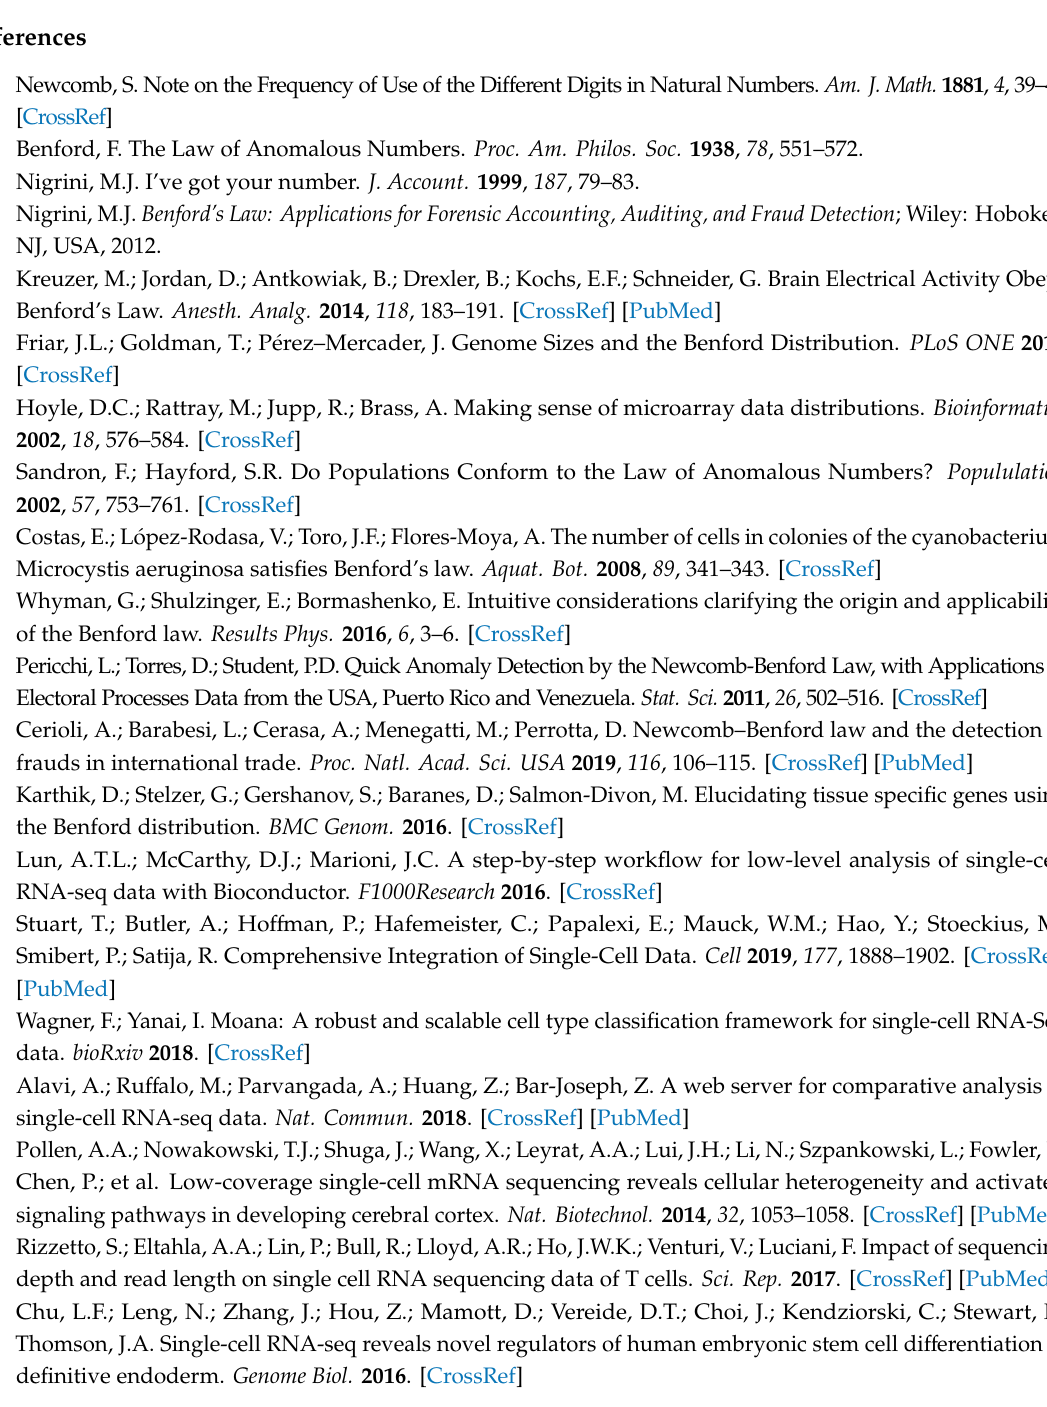
group-based, cell-centered polygenic scores (PS), calculated across the top 200 marker genes as detected by the Seurat package; Figure S5: Distribution of group-based, cell-centered polygenic scores (PS), calculated across the top 200 marker genes, as detected by MAST; Figure S6: Visualization of cell-type clustering separation using principle component analysis upon six polygenic scores, calculated based on 200 Seurat and MAST DE genes of each cell type; Figure S7: Visualization of cell-type clustering separation using tSNE analysis; Figure S8: First-digit distribution of gene-centered expression data for the 53 tissues included in the GTEx